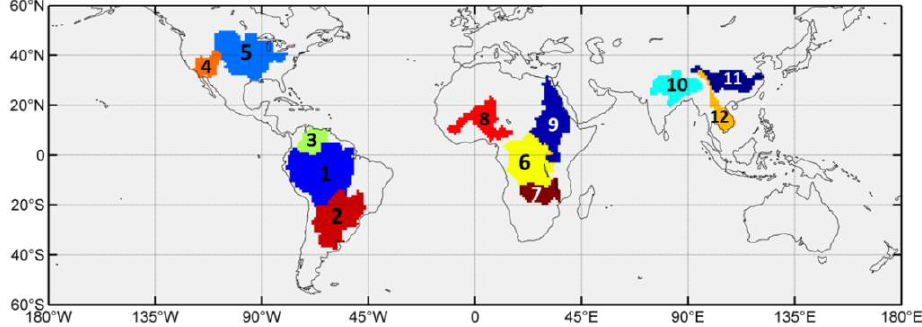
Figure 7. Selected major river basins in the tropics and subtropics (1 — Amazon, 2 — La Plata, 3 — Orinoco, 4 — Colorado, 5 — Mississippi, 6 — Congo, 7 — Zambezi, 8 — Niger, 9 — Nile, 10 — Ganges, 11 — Yangtze, 12 — Mekong). Table 2. Statistics of interannual and climate-induced TWS changes for selected major river basins.